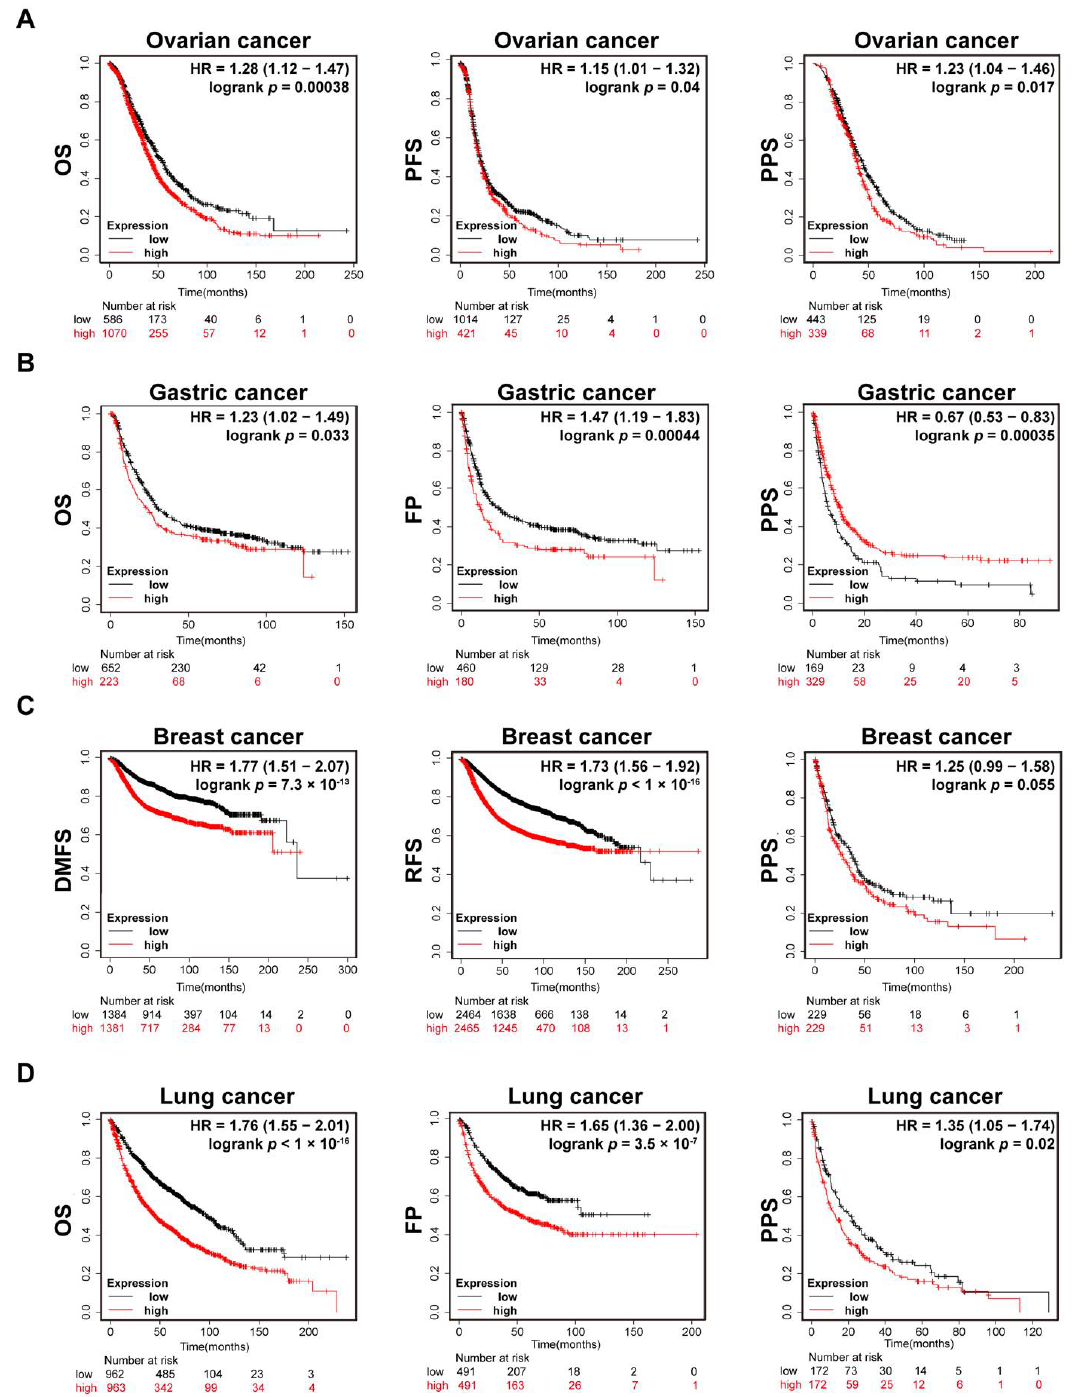
Figure 3. Prognosis analysis data of UBE2C in pan-cancer. ( A ). Kaplan–Meier plotter analysis of the relationship between UBE2C expression levels and clinical prognosis in ovarian cancer showed that higher UBE2C expression levels predicted poor overall survival (OS), progression-free survival (PFS), and post-progression survival (PPS). ( B ). Kaplan–Meier plotter analysis showed that higher levels of UBE2C were associated with worse OS and shorter times to first progression (FP) but better PPS in gastric cancer. ( C ). Kaplan–Meier plotter analysis showed that a higher level of UBE2C in breast cancer was related to worse distant metastasis-free survival (DMFS), disease-free survival (RFS), and PPS. ( D ). Kaplan–Meier plotter analysis suggested a strong relationship between the upregulation of UBE2C and poor OS, FP, and PPS in lung